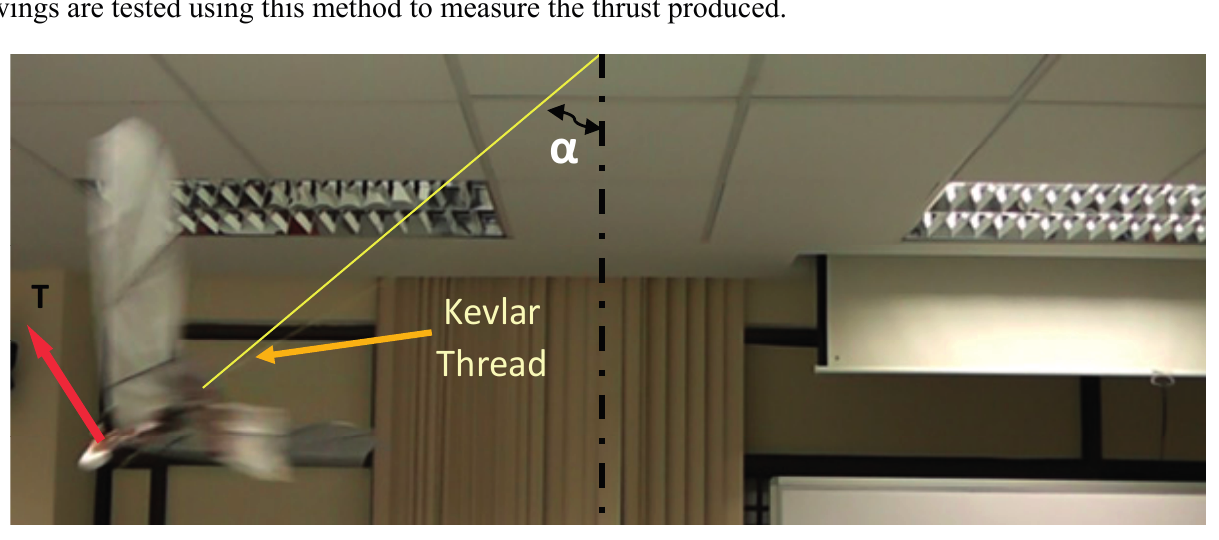
Figure 28. Thrust measurement of swing